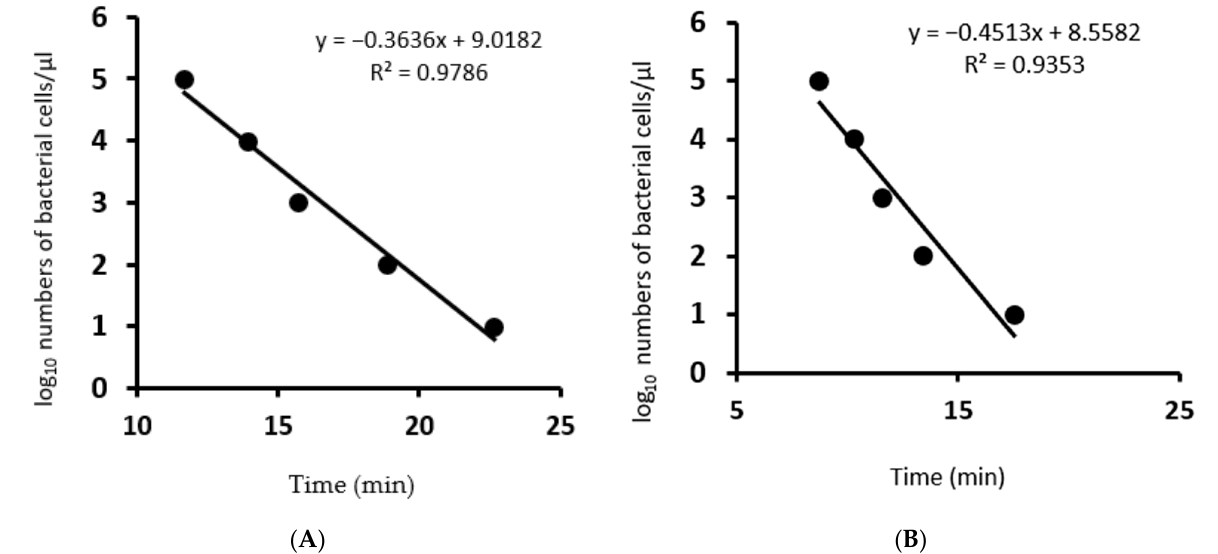
Figure 2. Regression curves generated in the LAMP assays for serial dilutions of live bacterial culture. Time to positive (Tp) is plotted against the log 10 bacterial cells µL − 1 . ( A ): Pseudomonas syringae pathovar pisi primers, ( B ): Pseudomonas syringae pathovar syringae primers.